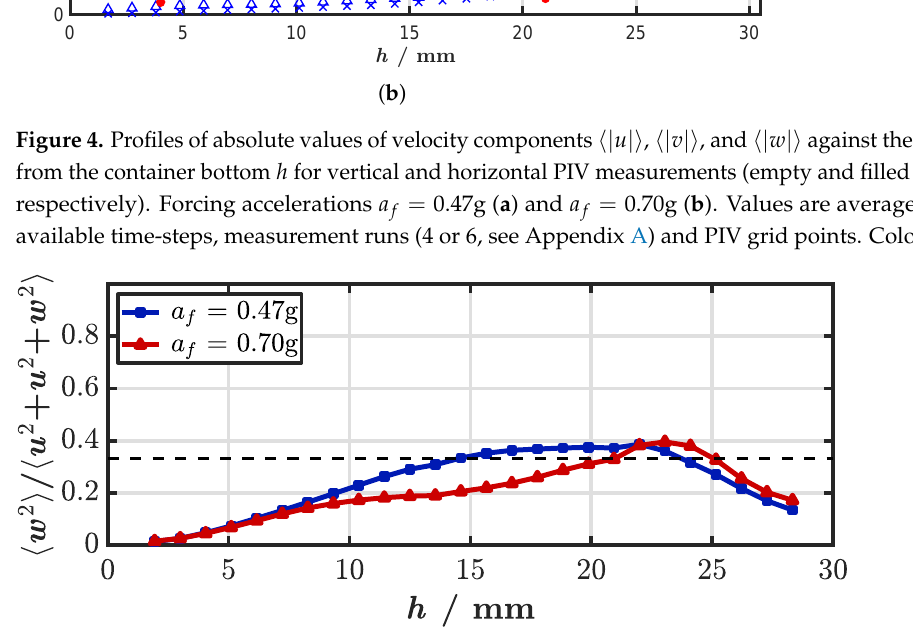
Figure 5. Average ratio of flow kinetic energy in the vertical direction to the total flow kinetic energy along the height from the container bottom h for forcing accelerations a f = 0.47 g and 0.70 g (blue squares and red circles). The horizontal dashed black line shows the 3D isotropic turbulence case at a value of 1/3. Color